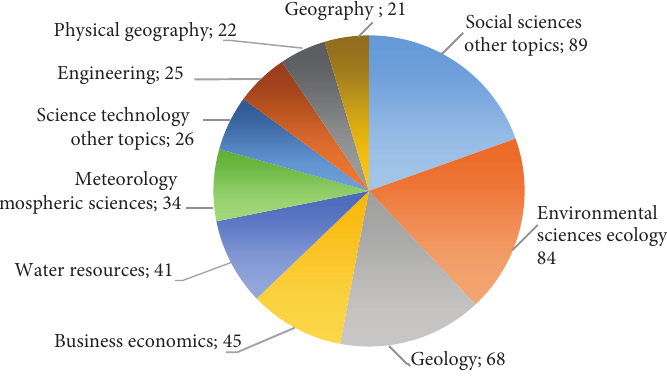
Figure 3. The top 10 research directions of the publications related to